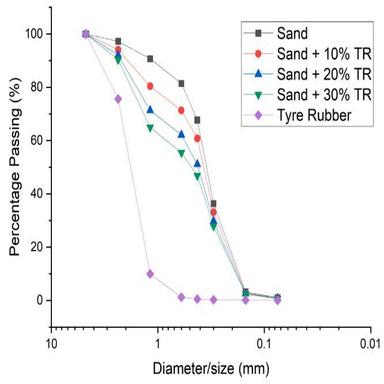
PSD curve for sand and sand-tyre rubber mixes.